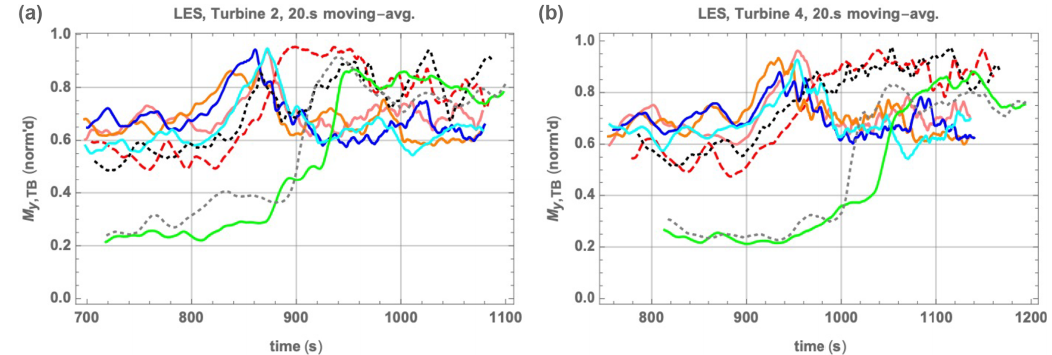
Figure 17. Raw tower-base fore–aft moment M tbfa for turbines 2 and 4; note that for commercial/proprietary reasons, all values have been non-dimensionalized by a single constant. Color/case legend as in Figs. 11–12, 14–16, 18–19, and 22–23.